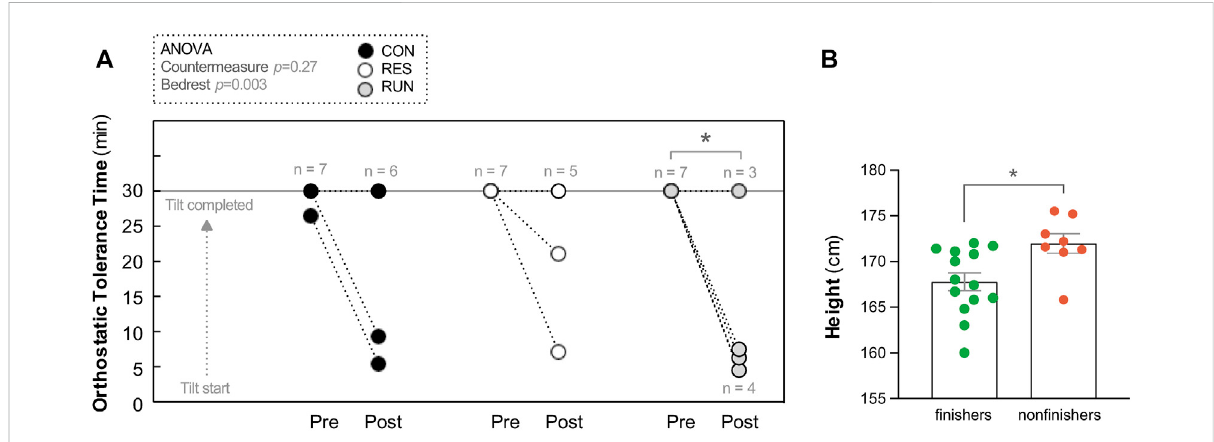
FIGURE 4 Orthostatic tolerance during a 30-min 75 ° head-up tilt test. Orthostatic tolerance time (OTT) (A) . Tilt was performed before (Pre) and immediately after (Post) 90-day head-down bedrest. Each circle represents the individual OTT. * p < 0.05 vs. OTT Pre. Body height of fi nishers vs. non- fi nishers post-HDBR (B) (all groups pooled together). Data are presented as the mean ± SEM, * p < 0.05 vs. fi